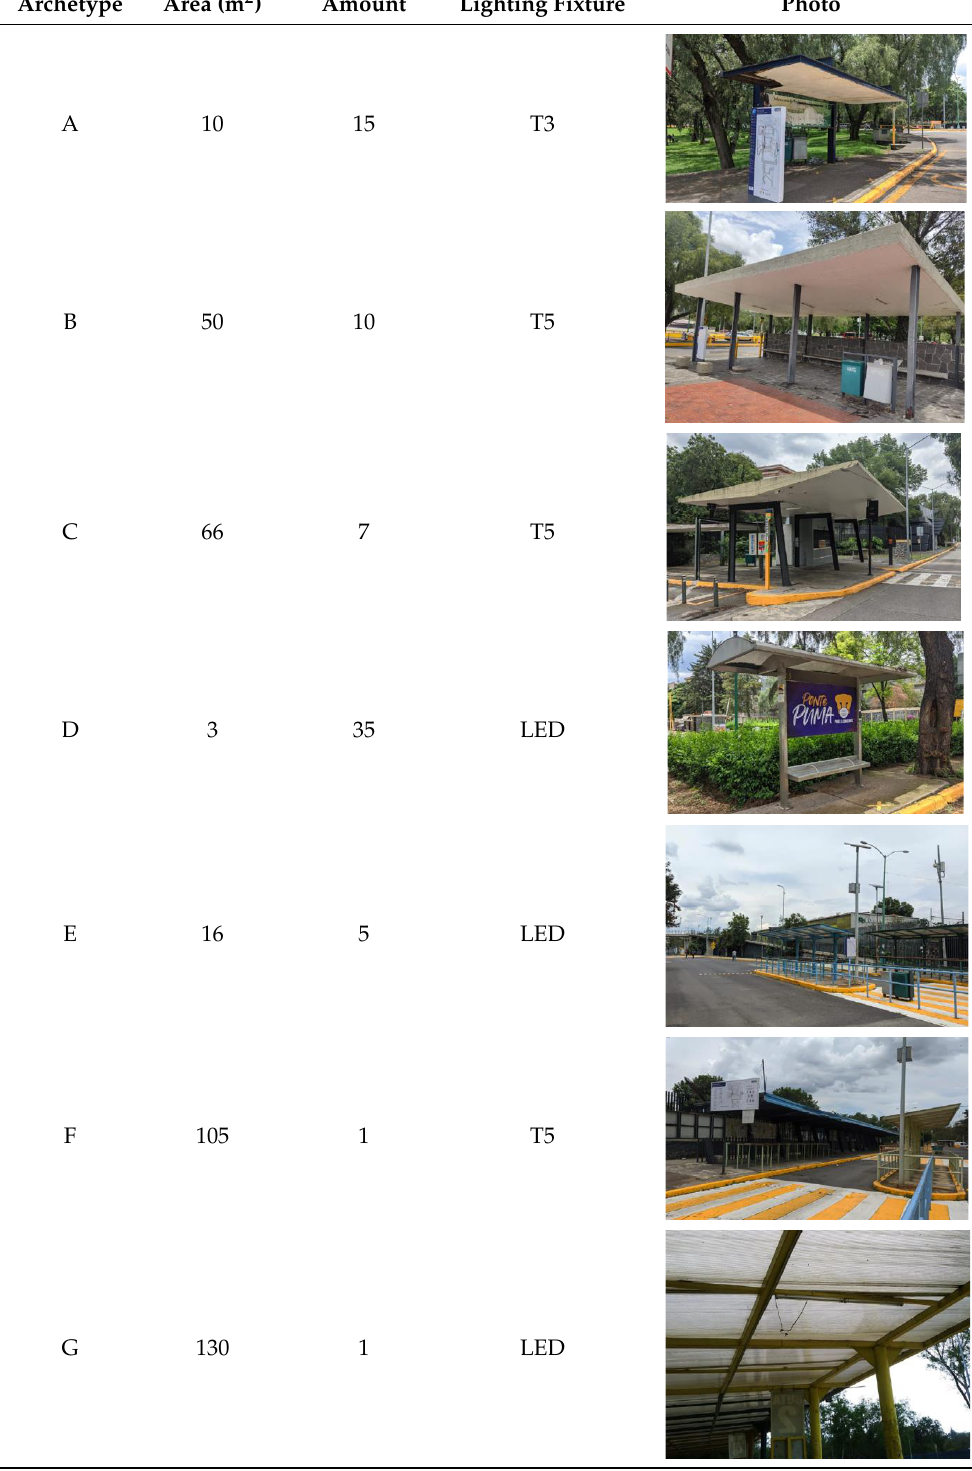
Table 2. Archetypical bus stations on the campus.